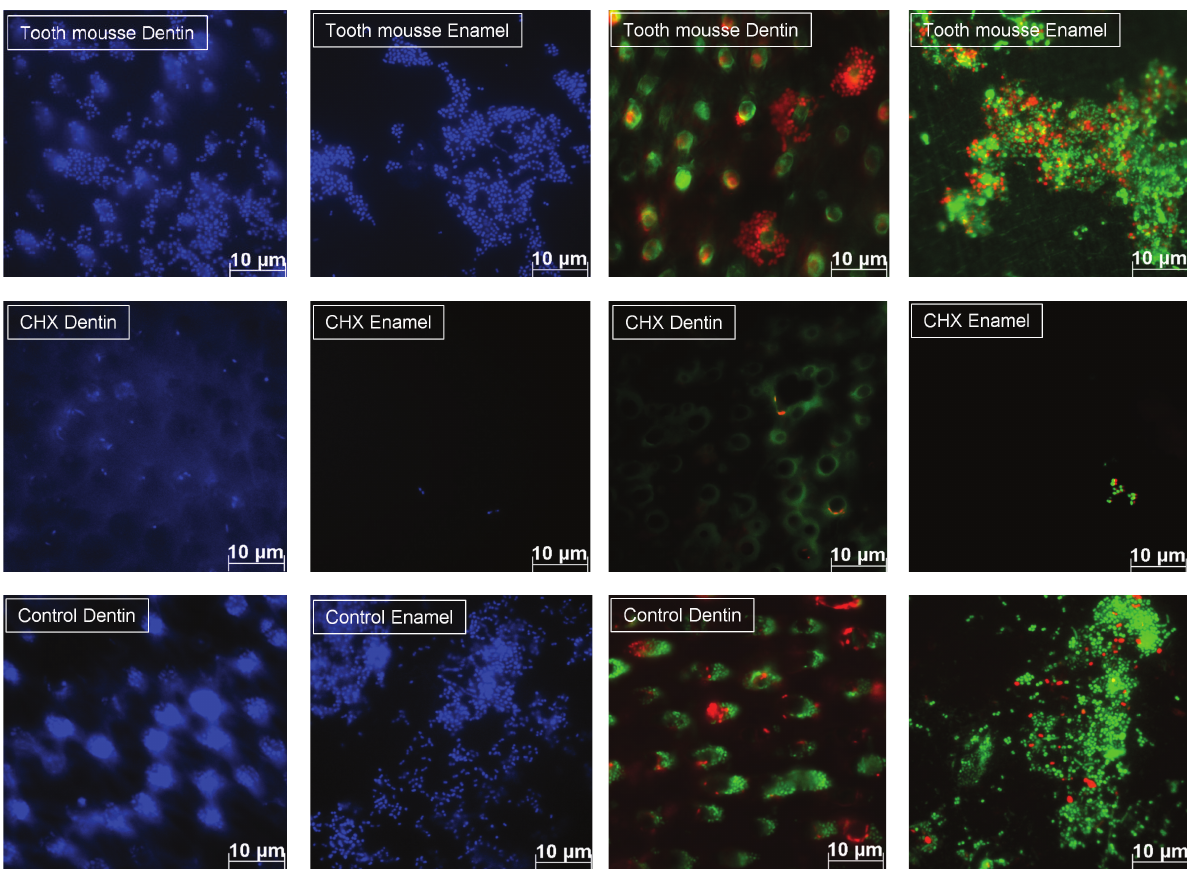
Figure 1: DAPI staining (blue) and live/dead staining (red/green): representative images of CPP/ACP samples and control-specimens (CHX, no rinse) after 8 h oral exposure. On enamel control samples vast areas were coated by bacterial aggregates or monolayers; dentin samples show a preferred colonization at the dentin tubules. Initial rinses of chlorhexidine reduced the bacterial adhesion considerably. CPP/ACP had no impact on the amount of adherent bacteria, as compared with unrinsed controls.